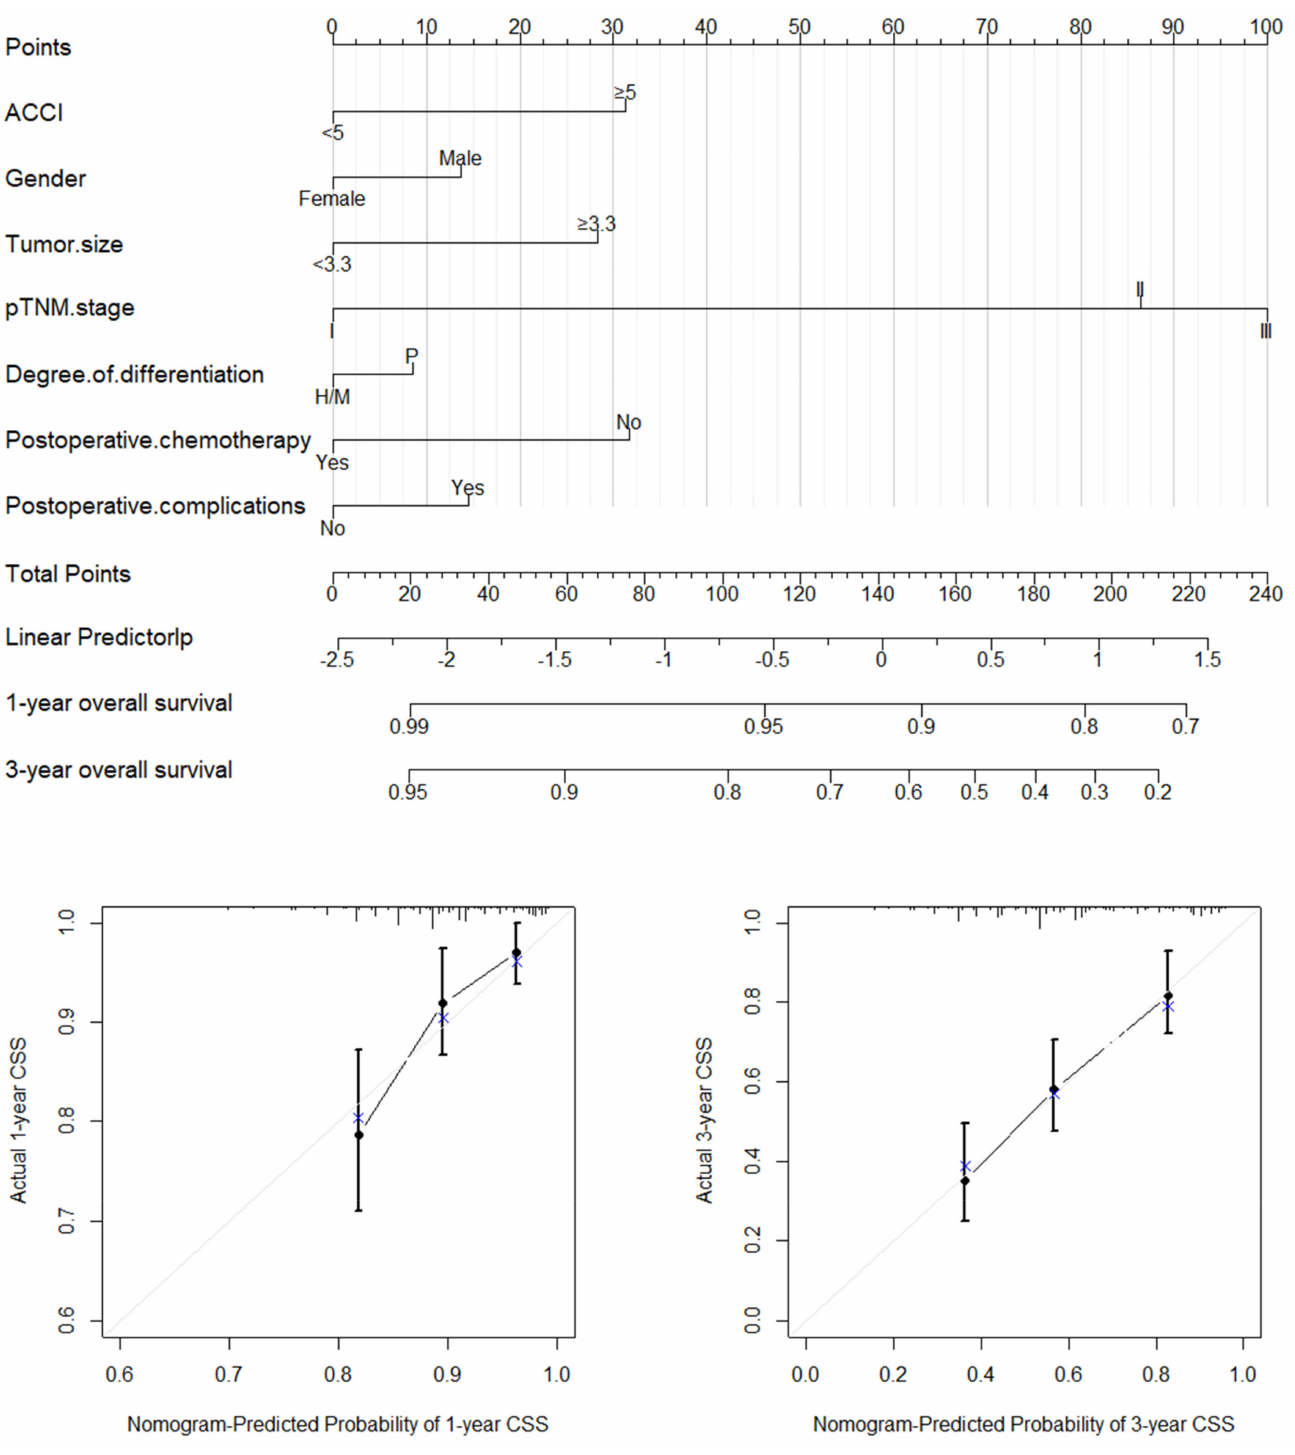
Figure 3. Nomogram plot and calibration curves of the 1 − year and 3 − year